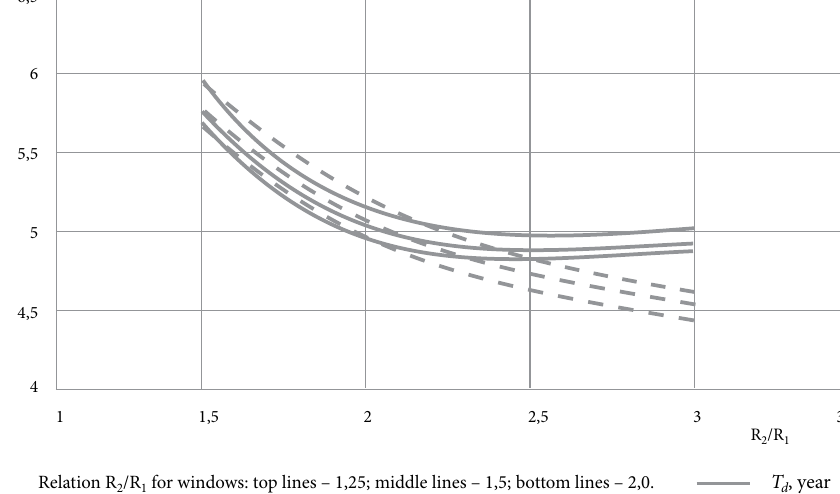
Relation R 2 /R 1 for windows: top lines – 1,25; middle lines – 1,5; bottom lines – 2,0. T d , year Coefficient of thermal efficiency of heat recovery devices k ef =